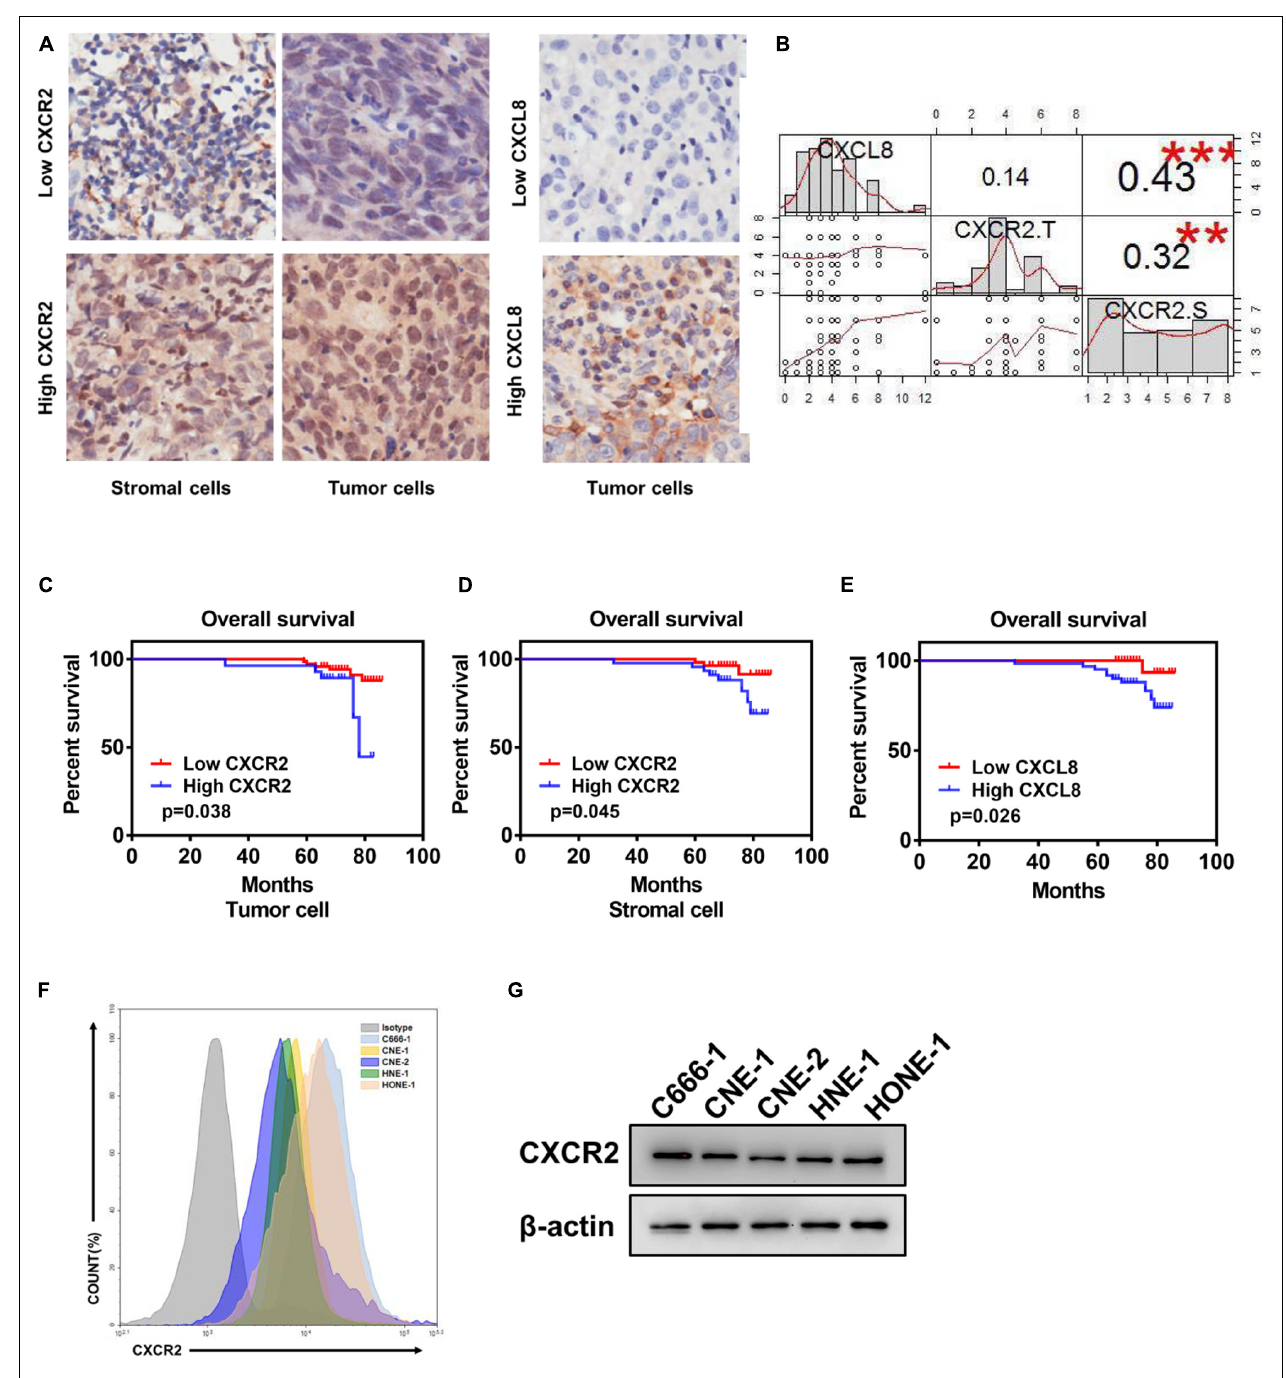
FIGURE 1 | Elevated CXCR2 and CXCL8 co-expression levels in NPC correlate with poor prognosis. (A) Representative immunohistochemistry images showing CXCR2 expression in stromal and tumor cells in different individual NPC tissue (left) and CXCL8 expression in other NPC tissues (right). Magnification, 20 × . (B) Correlation analysis between CXCR2 and CXCL8. CXCL8 expression and CXCR2 expression in tumor cells was significantly positively associated with CXCR2 expression in stromal cells, R = 0.43, p < 0.001 and R = 0.32, p < 0.01, but no association was found between CXCR2 expression in tumor cells and CXCL8 expression in stromal cells, R = 0.14, p > 0.05. Statistical analysis was performed using the Pearson’s correlation coefficient and linear regression. (C–E) According to IHC score, samples from NPC patients ( n = 99) were divided into two groups based on low or high expression of the indicated markers, including CXCR2 in tumor and stromal cell and CXCL8. Overall survival was significantly negatively associated with the levels of CXCR2 in tumor cells, CXCR2 in stromal cells and CXCL8, as displayed in Kaplan–Meier survival curves of OS, (C) p = 0.038; (D) p = 0.045; and (E) p = 0.026. (F–G) CXCR2 expression analysis of six NPC cell lines using flow cytometry and western blot. (IHC score, immunohistochemical analysis score; R, Spearman’s correlation).